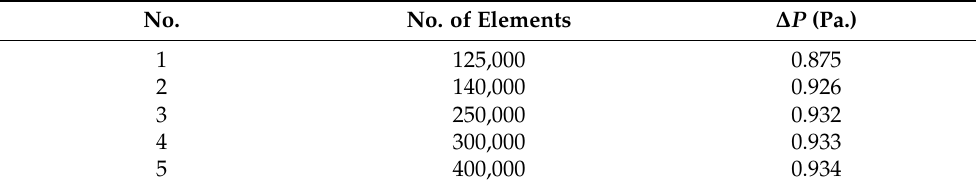
Table 1. Pressure drops in model at different grids.